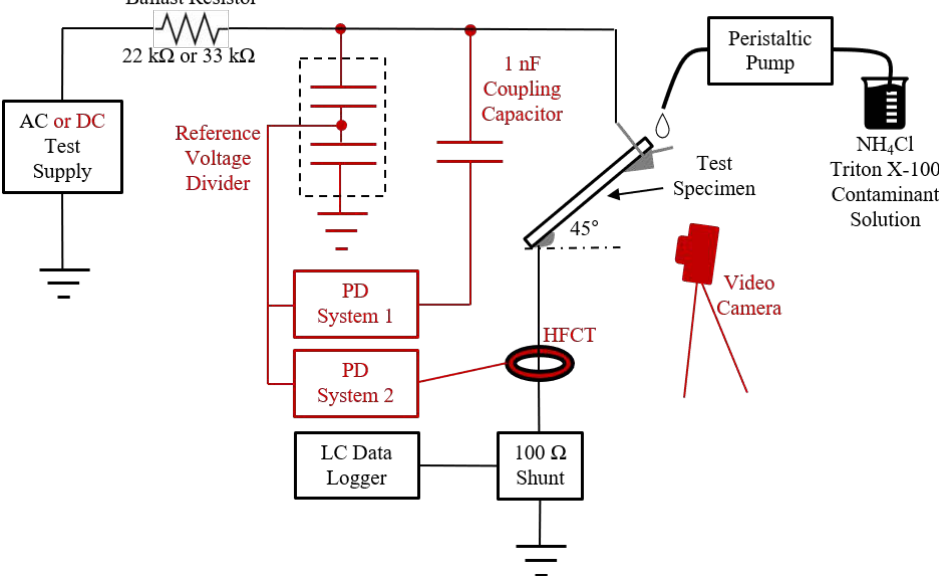
Figure 1. AC and DC inclined plane test (IPT) experimental setup. The test setup as prescribed by IEC 60587 is in black and the additional equipment employed in this study is in